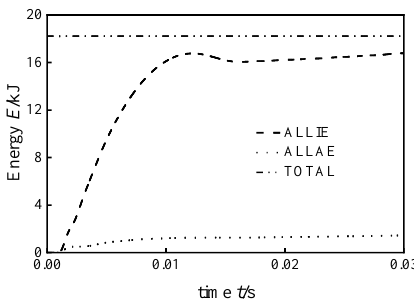
Figure 4. The energy–time history curve.